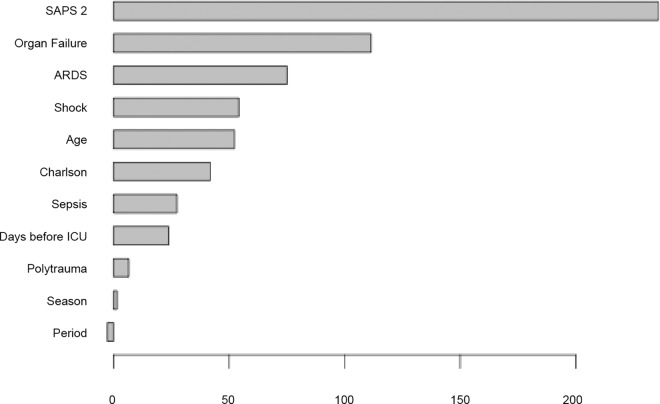
Permutation-Based Variance Importance Measure.The variables are ranked from the most important (top) to the least important (bottom). Variable importance is represented on the x-axis as the z-score. SAPS II: Simplified Acute Physiology Score II; ARDS: acute respiratory distress syndrome; Charlson: modified Charlson comorbidity index; ICU: intensive care unit.